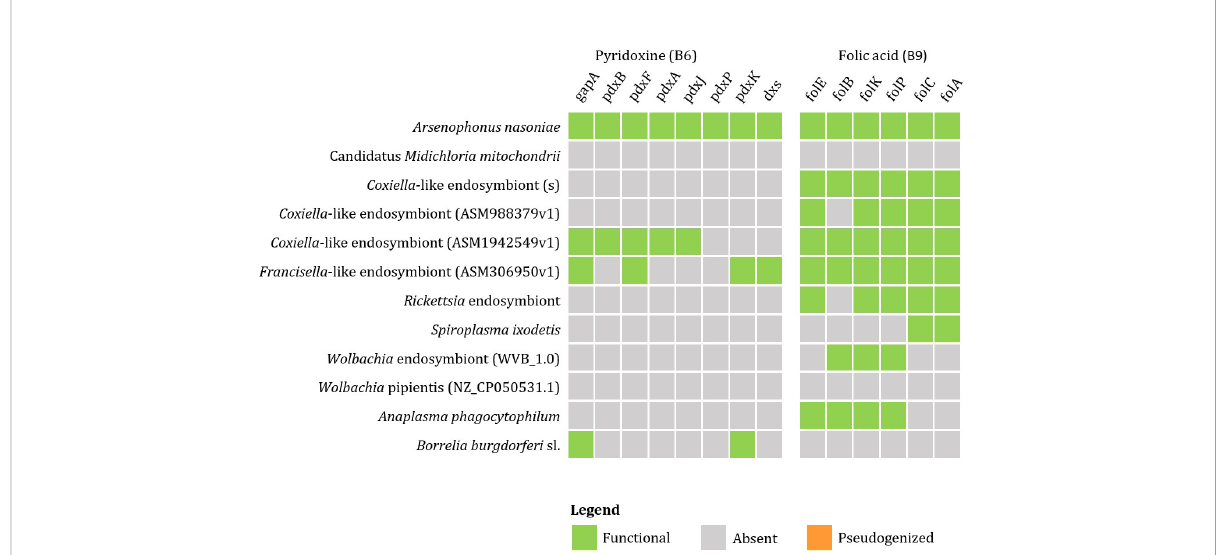
FIGURE 4 Schematic overview of endosymbiotic bacteria and pathogens transmitted by ticks with focus on gene clusters involved in vitamin B production (B6, B9). Color code: green – detected genes, grey – absent genes, orange – pseudogenized genes).